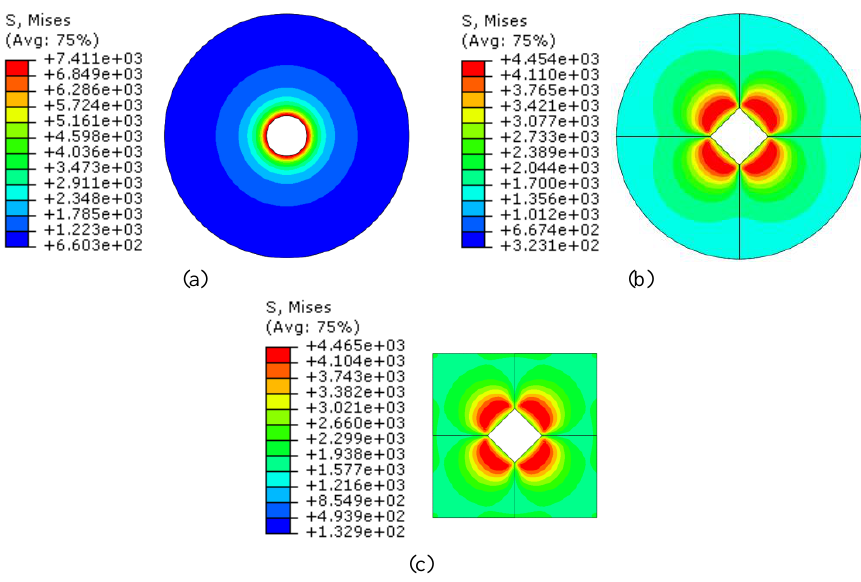
Figure 4. Von Mises stress distributions of cylinders: ( a ) BTD; ( b ) SLSD; and ( c ) DLSD.